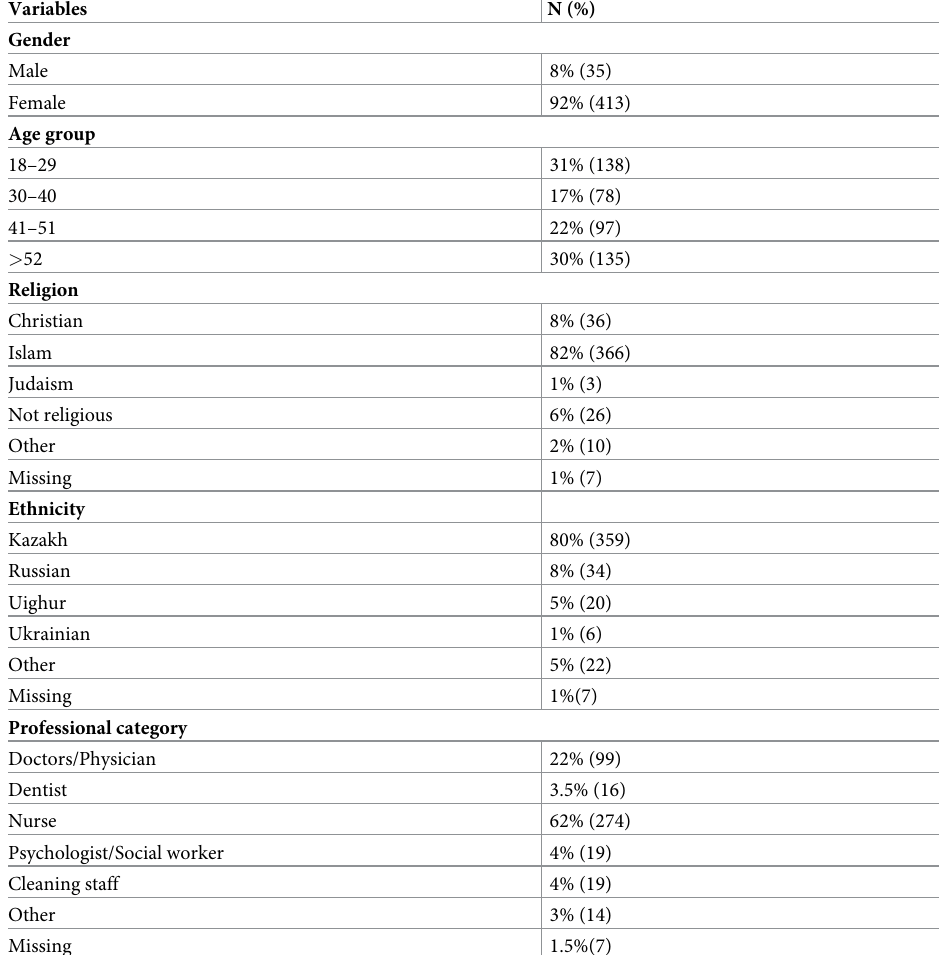
Table 2. Sociodemographic characteristics of the survey sample (n =